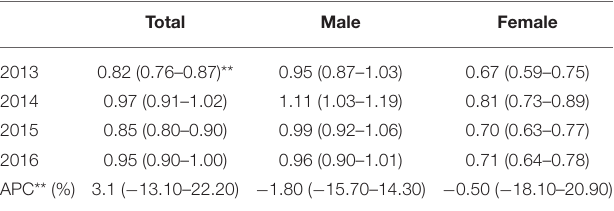
TABLE 8 | Annual age-standardized incidence rate of Crohn’s disease among urban employees in 23 provinces (municipalities, autonomous regions) of China from 2013 to 2016 (per 100,000 persons) *